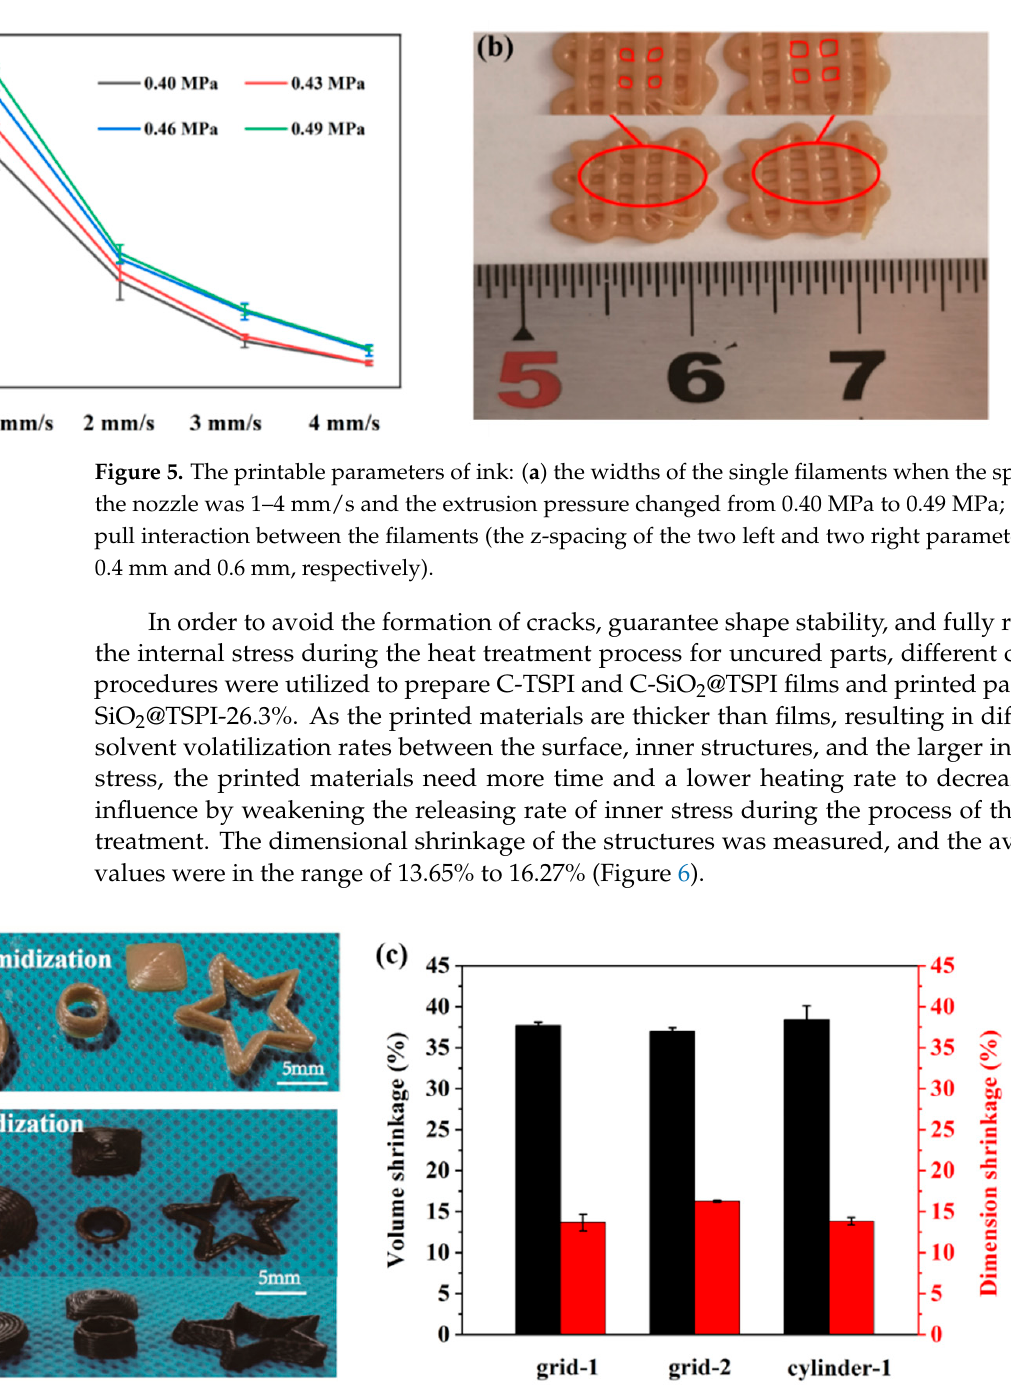
Figure 6. ( a , b ) Examples of printed structures before and after heat treatment; ( c ) the volume and dimensional shrinkage of the printed structures.